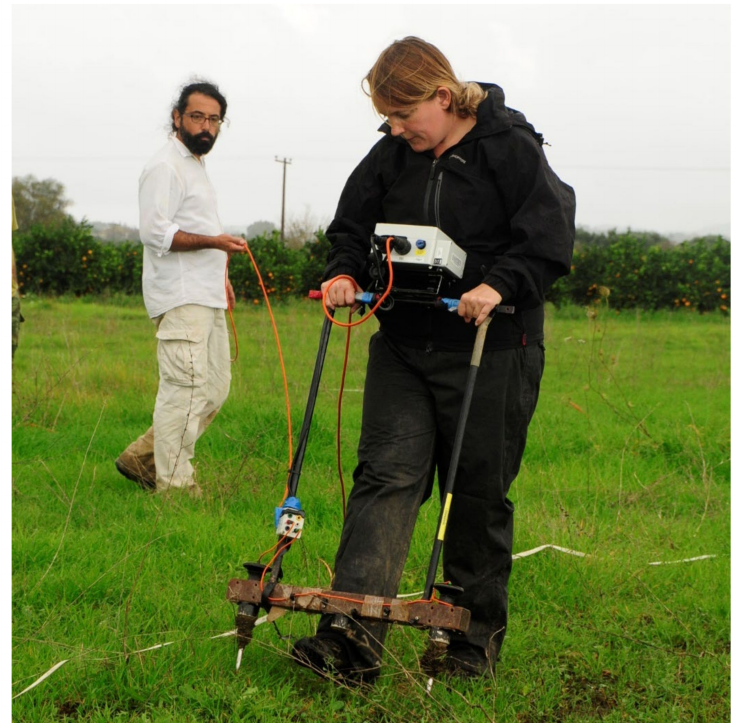
Figure 3. Geoscan Research RM85 Resistance Meter being used in the